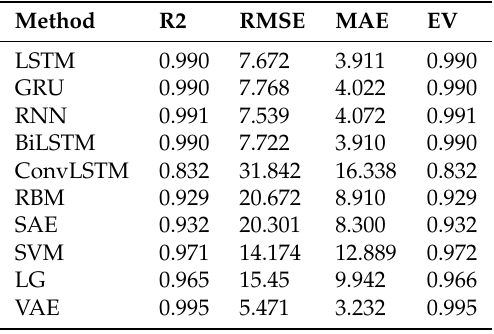
Table 3. Forecasting performance of the eight models based on testing data of the first